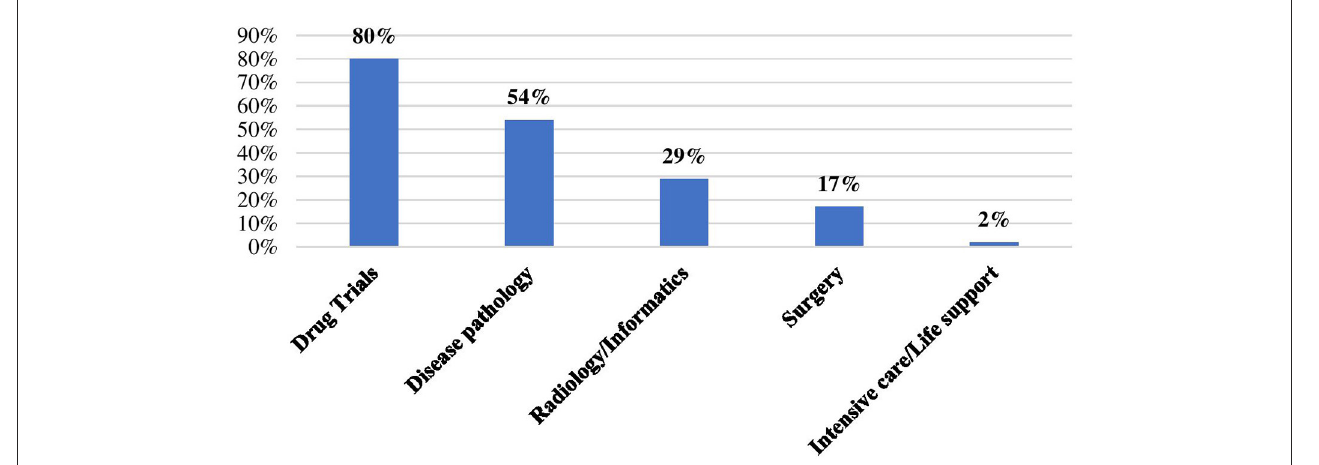
FIGURE3 Specific areas of ongoing health research projects by